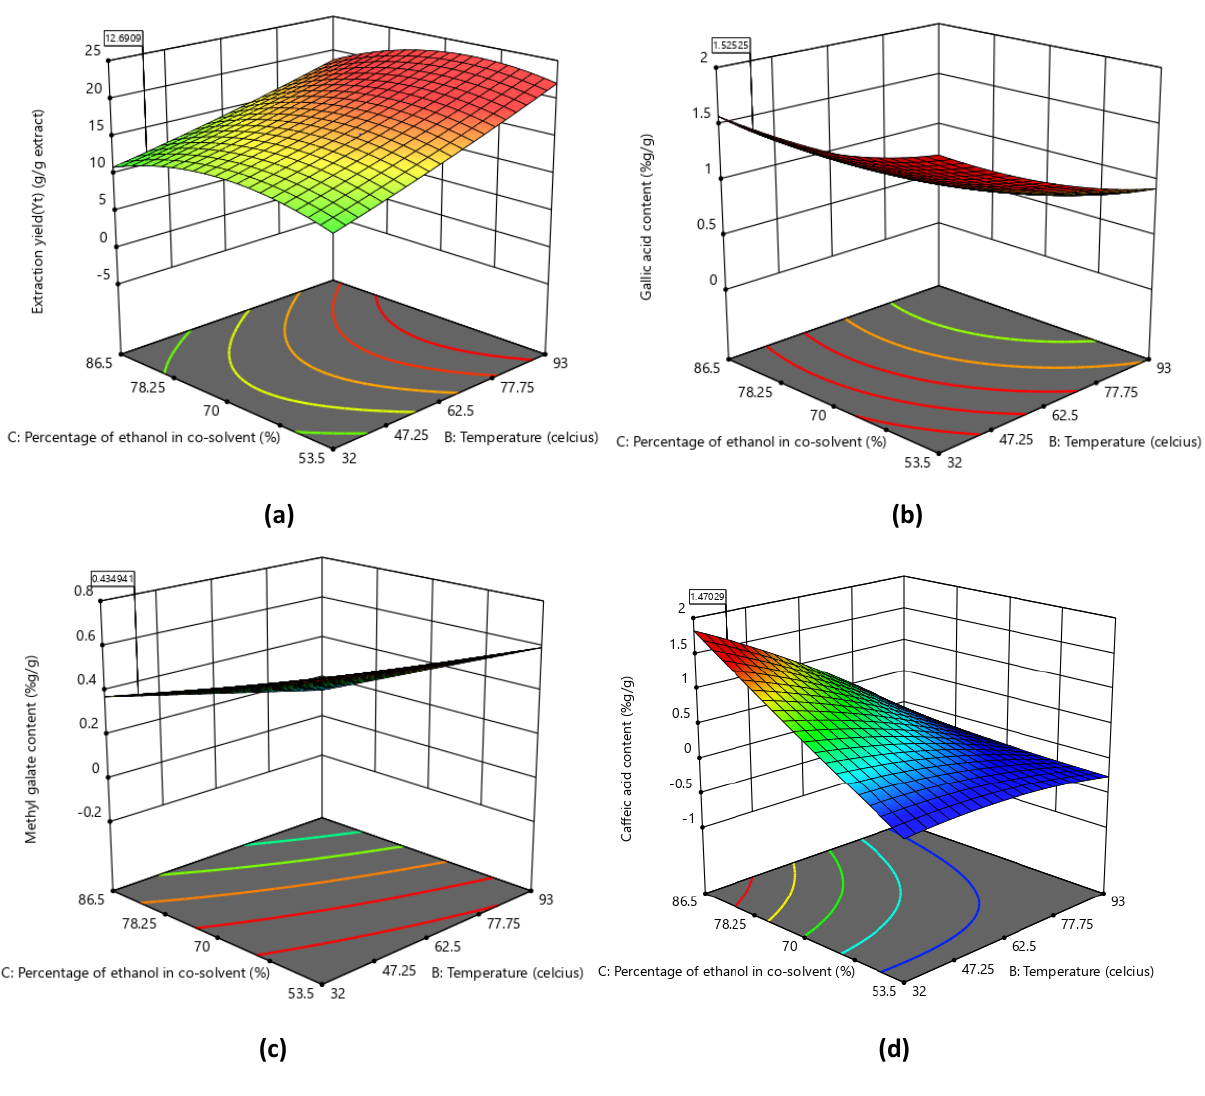
Figure 4. Effect of temperature and percentage of ethanol in co-solvent on ( a ) extraction yield,